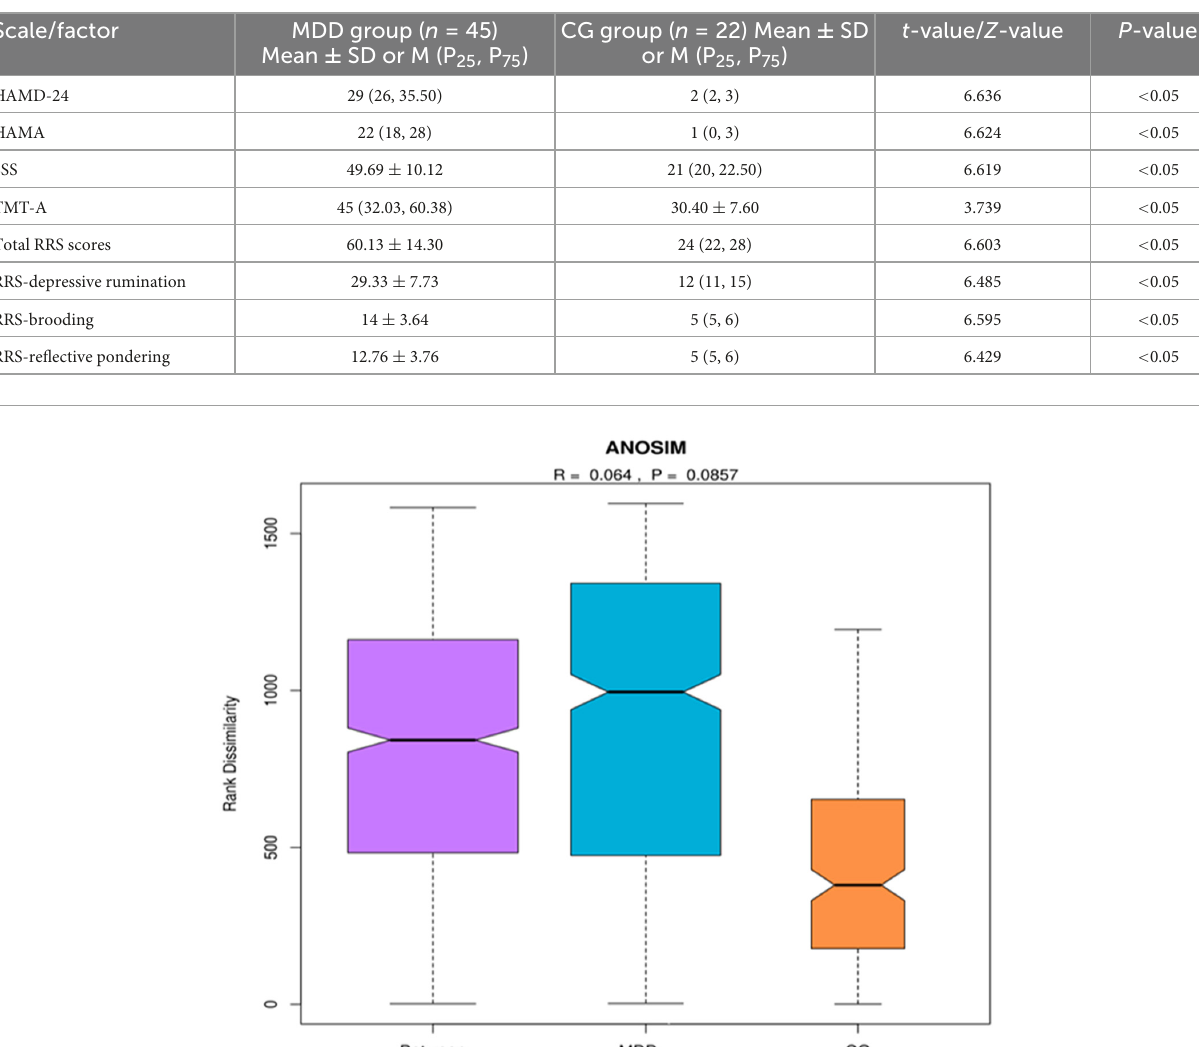
TABLE 2 Comparison of scale scores between the MDD group and the CG group.